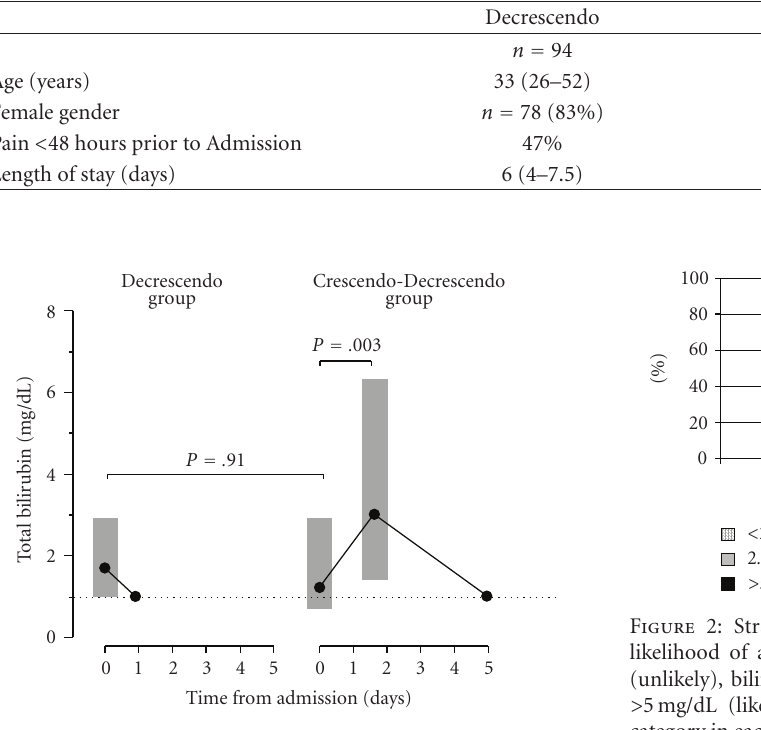
Figure 1: Trends of bilirubin levels during hospital stay. Data is presented as medians (solid circle) and interquartile range (grey box). Bilirubin levels on admission (Day 0) are shown for both the Decrescendo and Crescendo-Decrescendo groups. Time to peak bilirubin values are shown for Crescendo-Decrescendo Group. Median time to normalization of bilirubin levels depicted for both groups. There was no significant di ff erence in bilirubin level on admission between those patients in the Decrescendo group compared to those in the Crescendo-Decrescendo group ( P = . 91). The peak bilirubin levels in the Crescendo-Decrescendo group of patients were significantly higher than the levels on admission ( P = . 003). Dashed (--) line shows normal bilirubin level (1mg/dL).